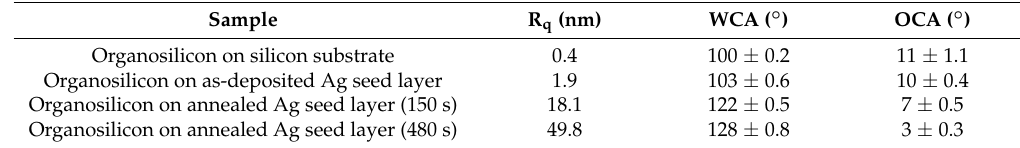
Figure 6. Water contact angle of: ( a ) the organosilicon film directly deposited onto the silicon substrate; and ( b ) the film deposited onto the as-deposited Ag seed layer; as well as the films deposited onto the annealed Ag seed layers deposited at for: ( c ) 150 s; and ( d ) 480 s (the inset figures show the correspondent oleic contact angle). Table 2. Surface roughness, water contact angle, and oleic contact angle of the organosilicon film directly deposited onto the silicon substrate and deposited onto the as-deposited and annealed Ag seed